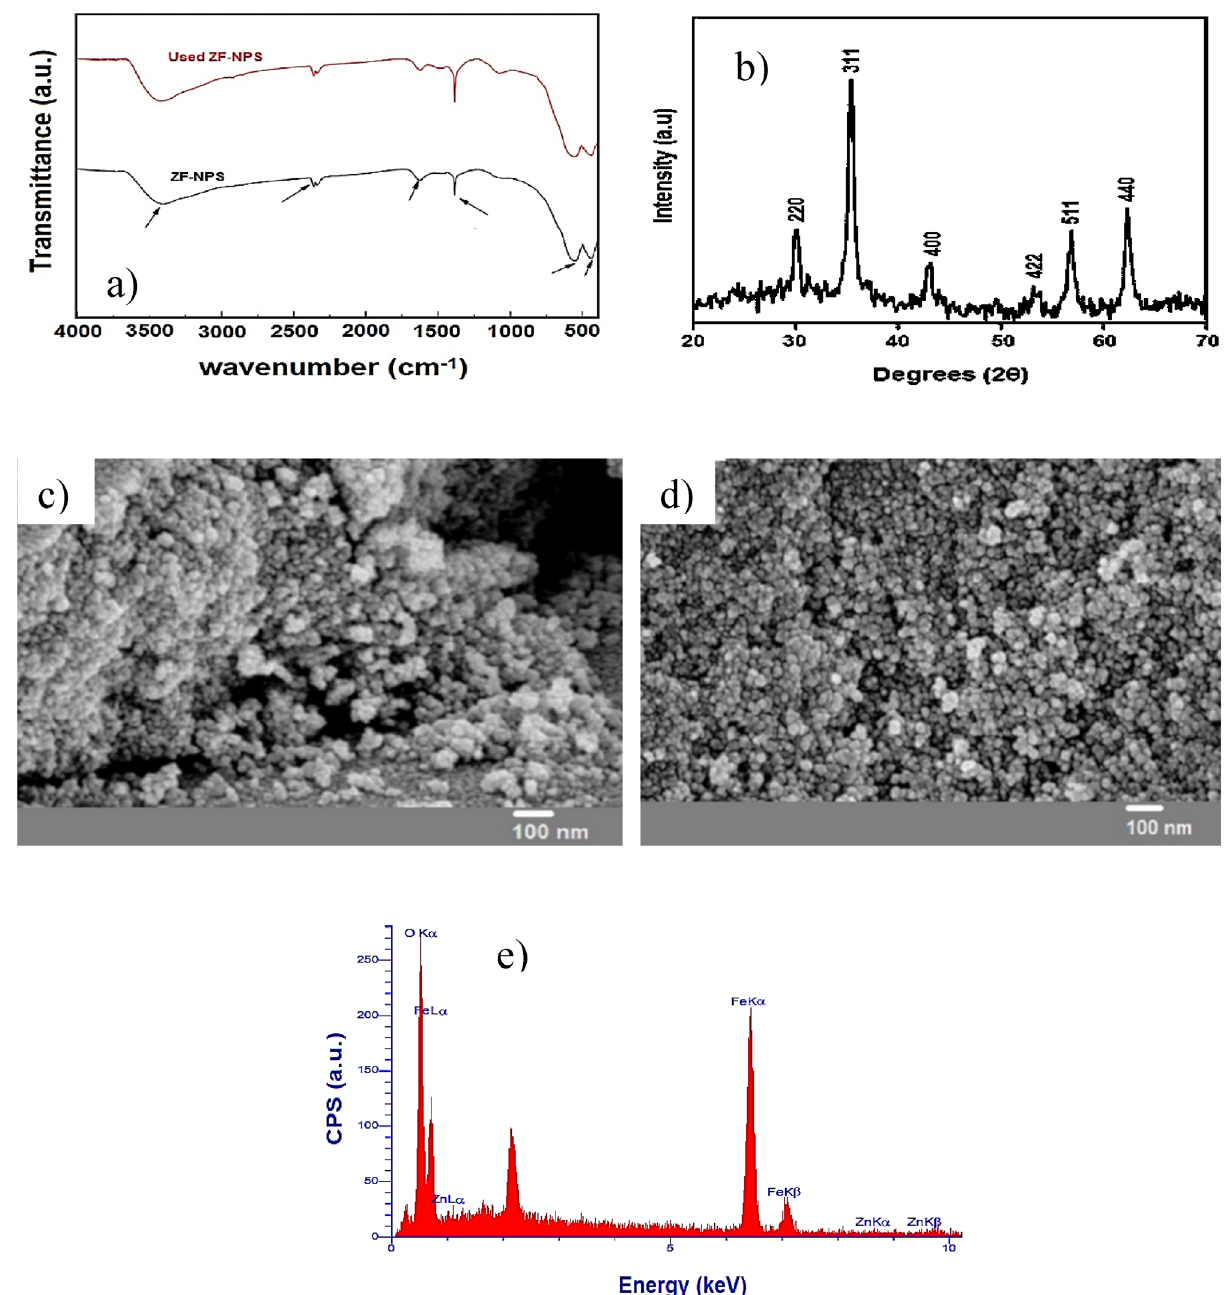
Figure 1. ( a ) FT-IR spectra, ( b ) X-ray diffraction pattern, ( c ), The SEM image of fresh ZF-NPS, ( d ) The SEM image of used ZF-NPS, and e) EDX